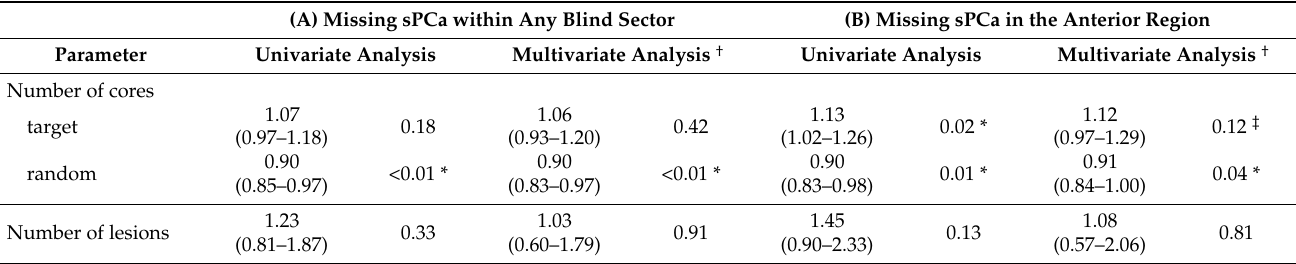
(A) Missing sPCa within Any Blind Sector (B) Missing sPCa in the Anterior